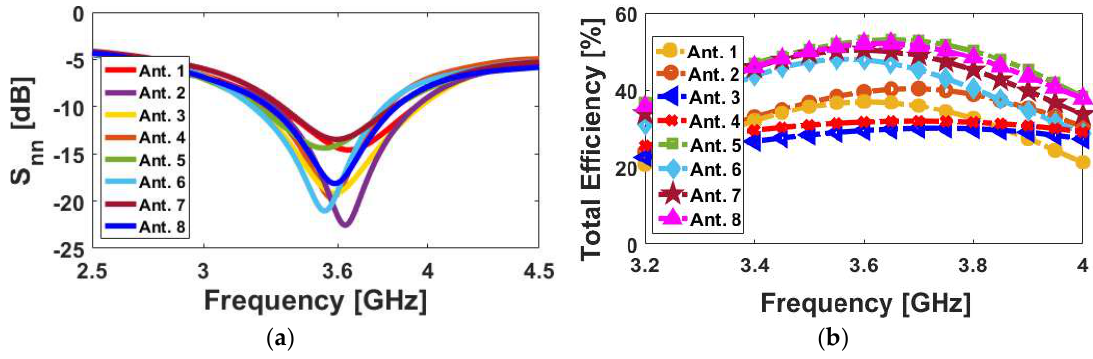
Figure 20. ( a ) S nn and ( b ) total efficiencies of the proposed smartphone antenna in Talk-Mode scenario.